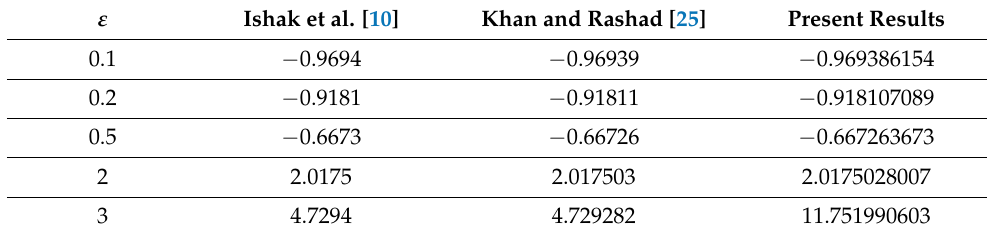
Table 1. Comparison of numerical values of F (cid:48)(cid:48) ( 0 ) at λ = 0, n = 1.